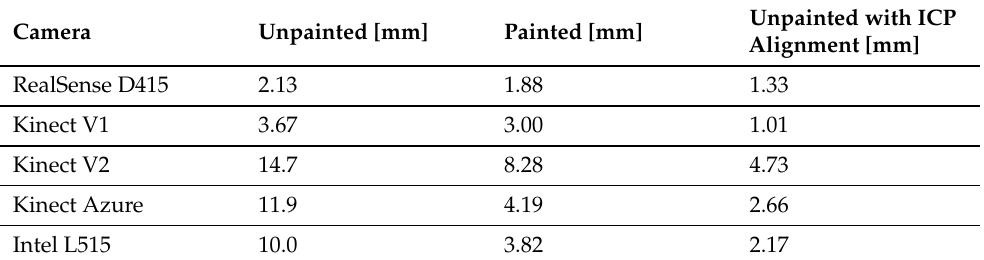
Table 2. Mean depth error for RGB-D camera scans of the grapes before and after they had been sprayed with paint. The cameras were located indoors and were positioned 600 mm from the grapes.